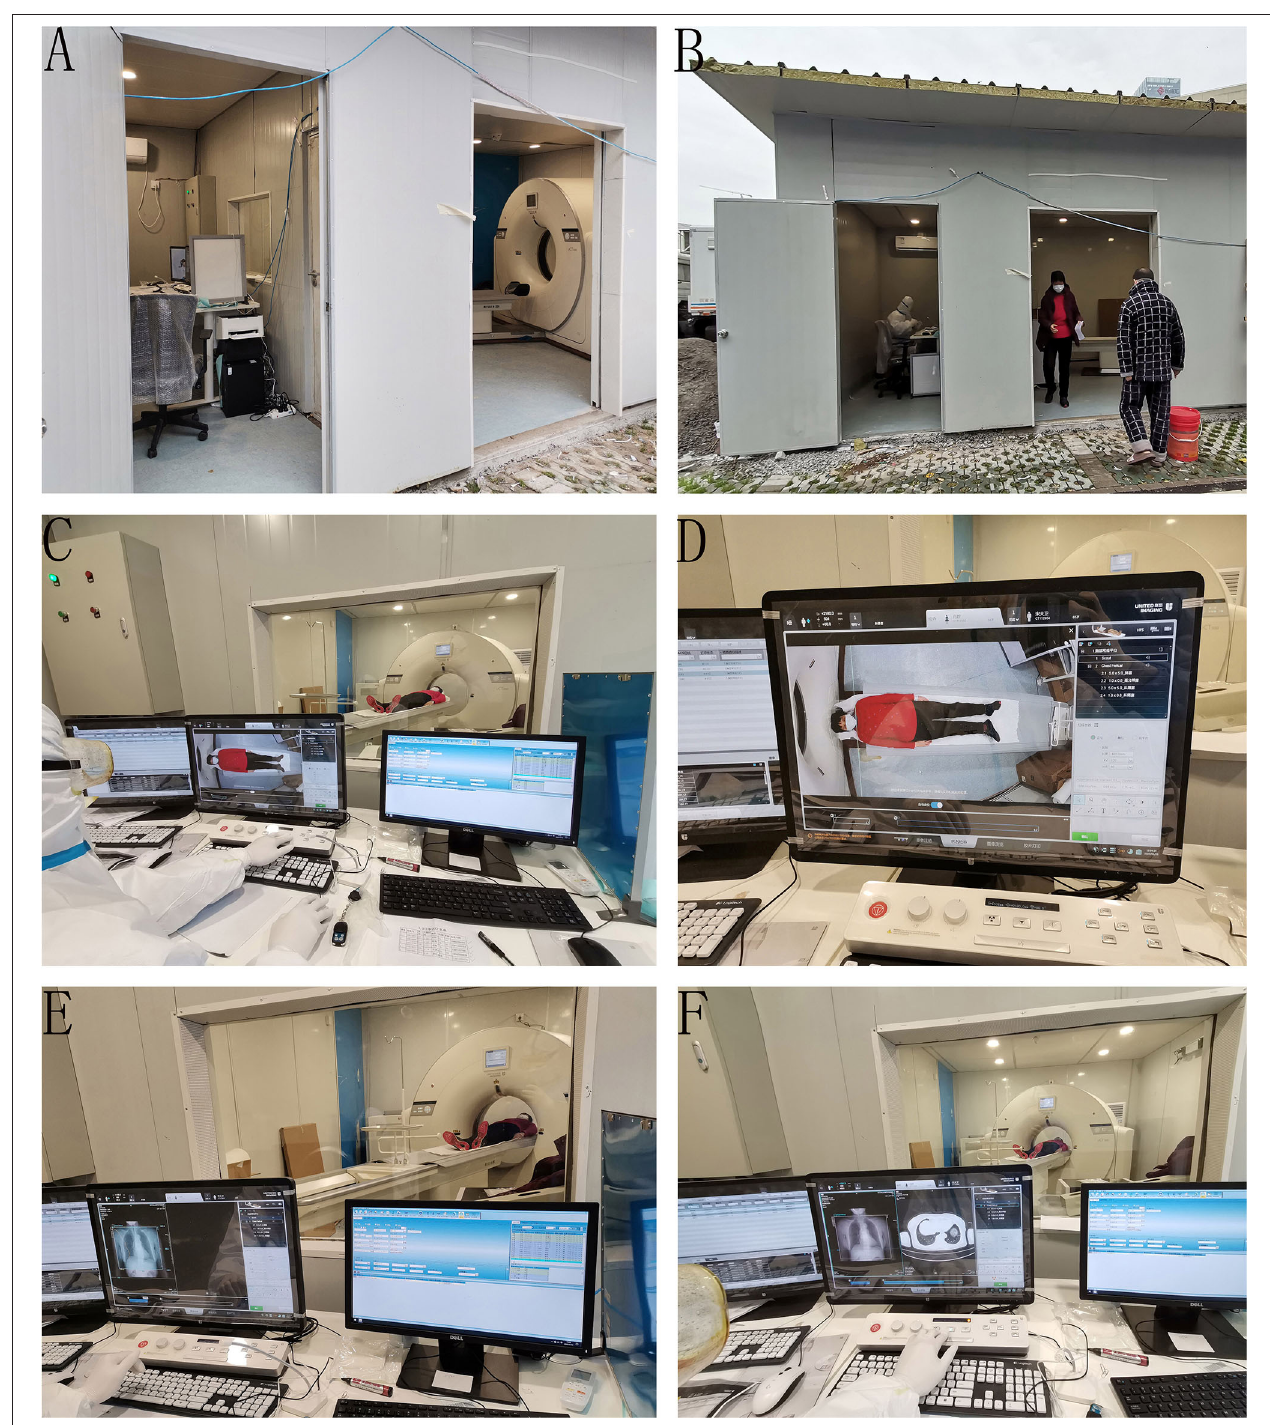
FIGURE 3 | Operation process of relocatable CT aided by automatic positioning technology. (A) The inner structure of the relocatable CT system. (B) The patients enter the scanning room from a separate door by themselves. (C) The examination bed moves to the ideal position automatically with the help of the camera-based intelligent auxiliary positioning system. (D) The patient’s real-time image is transmitted to a computer screen in the controlling room. (E) The automatic positioning system determines the scan range automatically. (F) The technologist starts scanning.